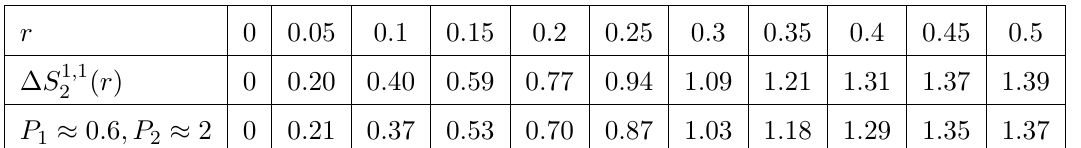
Table 1 . The di(cid:11)erence of 2nd R(cid:19)enyi entropies of a two-particle excited state with distinct mo- menta. The second row shows the exact values of the function (4.54). The third row shows the numerical values for the given momenta. The other parameters are m = 1, L = 10 and (cid:1) x = 0 : 01. We see that agreement is not as good as for the data in (cid:12)gure 5, especially for small ‘ . This is due to momenta being too small. More precisely min(2 (cid:25)=P 1 ; 2 (cid:25)=P 2 ; (cid:24) ) = 1 which is larger than some of the values of ‘ considered, a regime in which we do not expect our formulae to hold. However, even for such small momenta the disagreement with (4.54) is at worse around 10%.